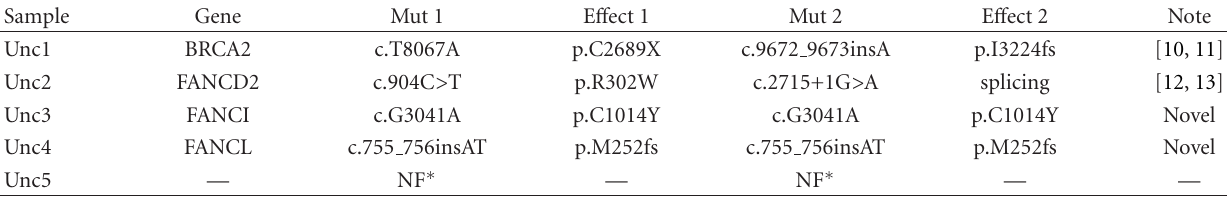
Figure 4: Prioritization scheme for the detection of disease-causing mutations by next-generation sequencing. Table 3: Mutation detection in unclassified FA